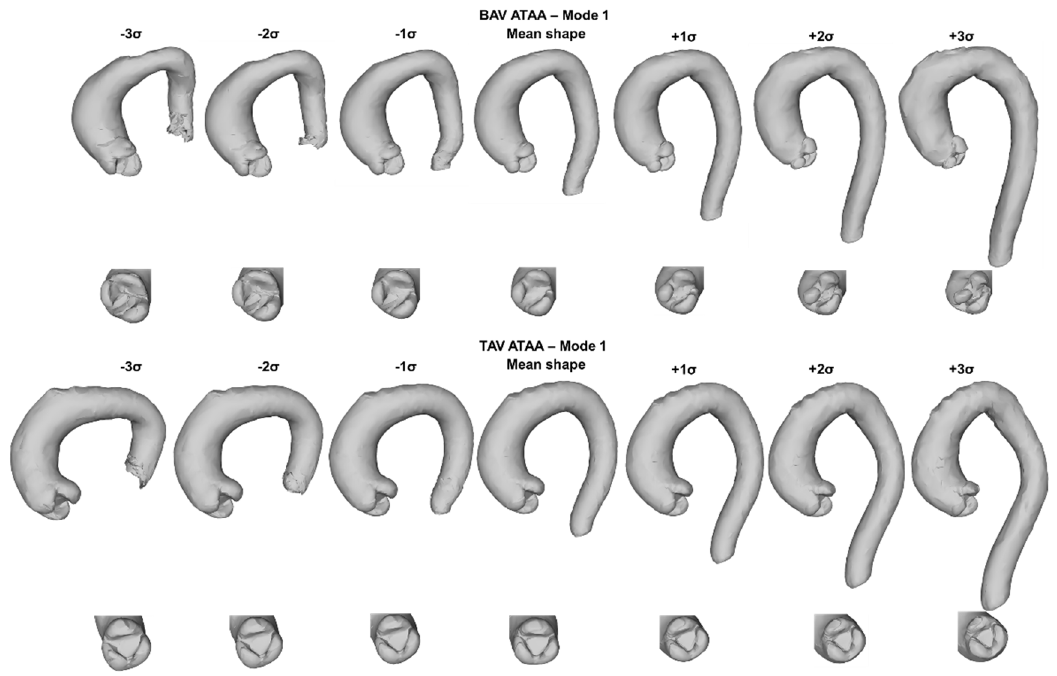
Figure 2. Graphic representation of ATAA and its valve for Mode 1 at different values of σ for both BAV ATAA and TAV ATAA.